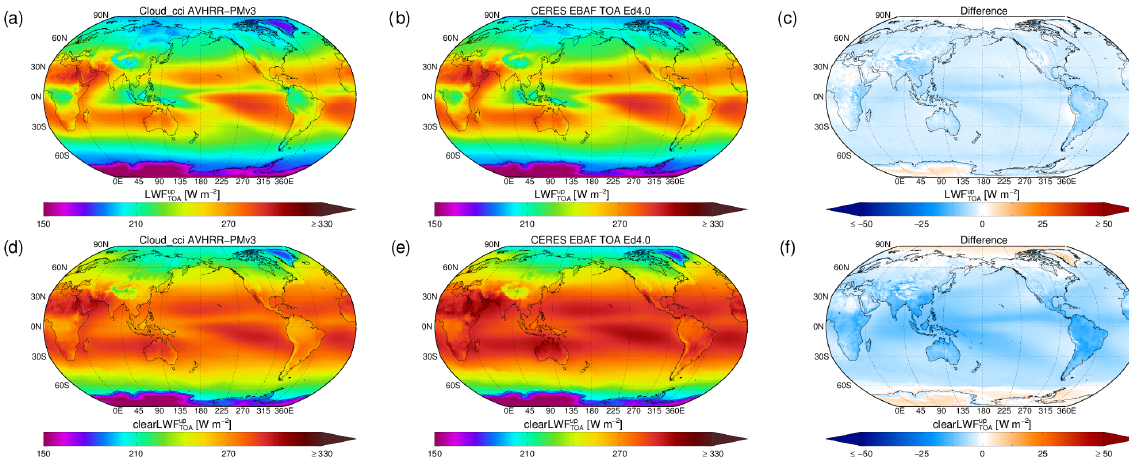
Figure 9. As Fig. 8 but for TOA upwelling longwave (LW) fluxes.